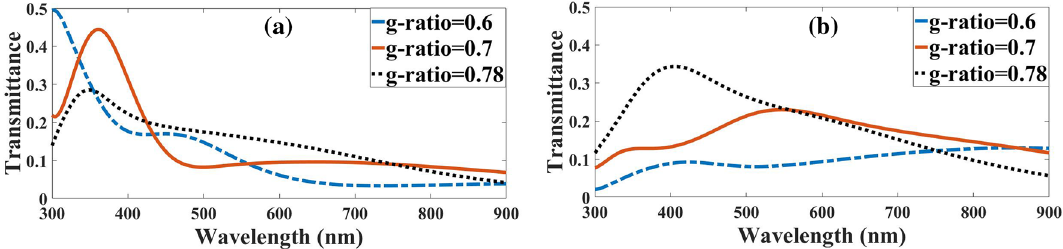
Figure 9. Light transmission spectra to the outputs of ( a ) axon and ( b ) myelin sheath for different g-ratios .